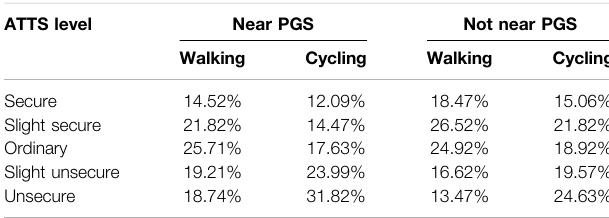
TABLE 4 | ATTS-level percentage comparison ATTS level Near PGS Not near PGS